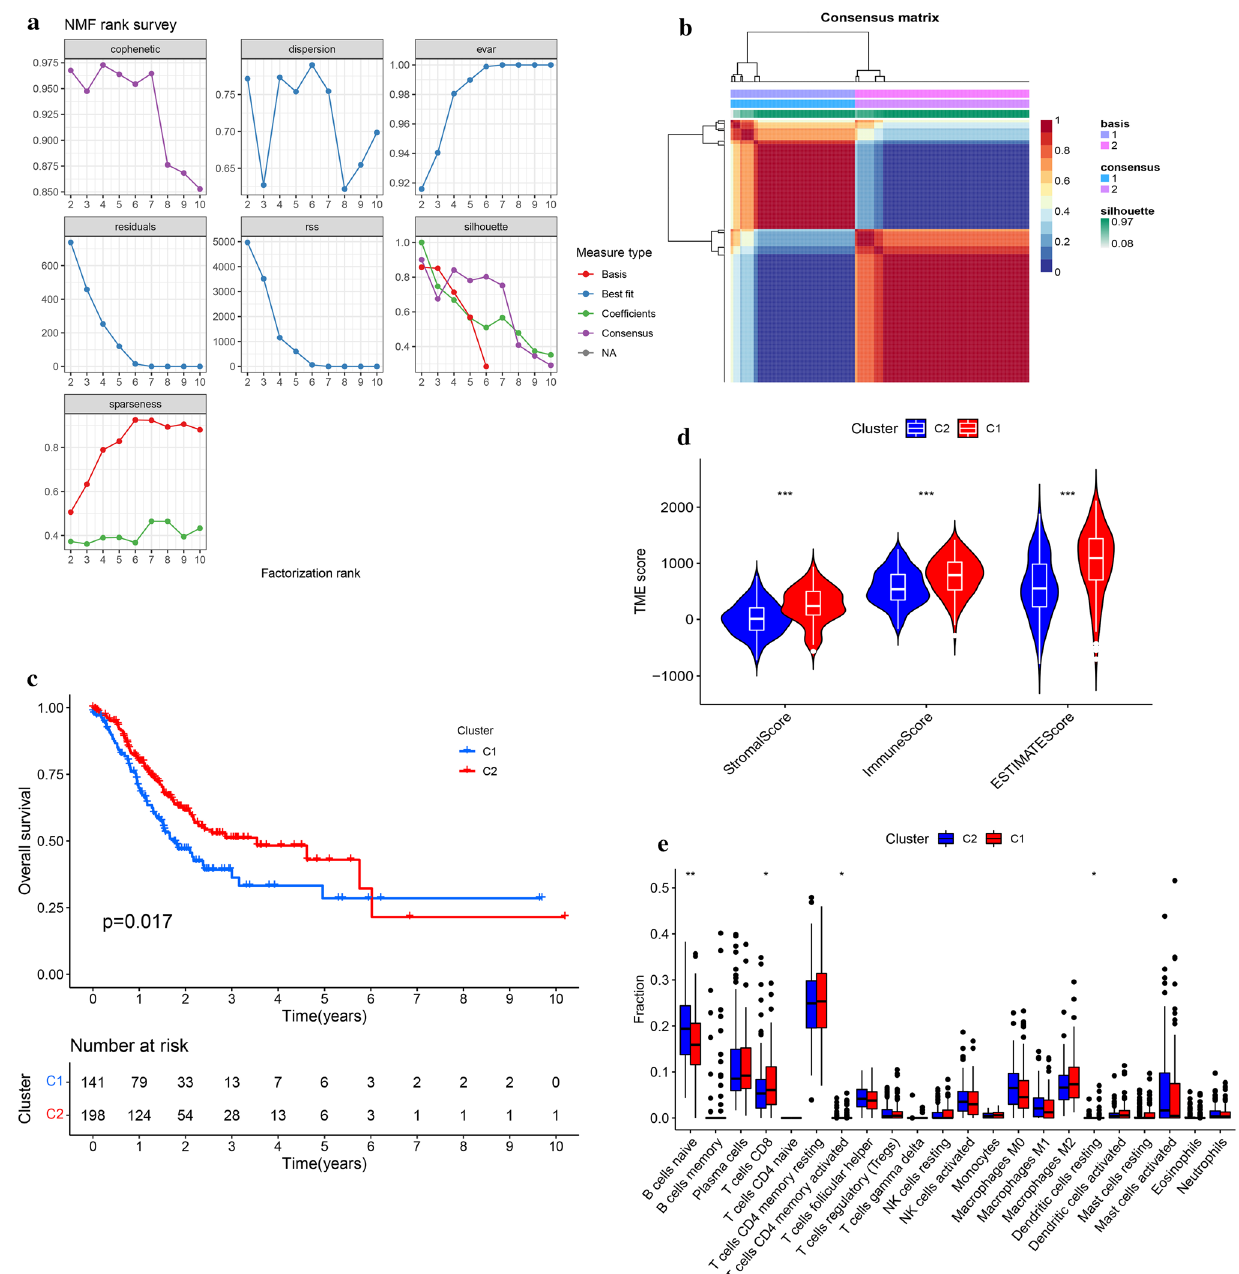
Fig. 3 Identification of DE-IRlncRNAs-based molecular subtypes. a The cophenetic, rss, and silhouette distributions when the number of clusters was set as 2–10. b Consensus map of NMF clustering. c The survival curves of 2 molecular subtypes. d Comparisons of immune, esti- mate, and stroma scores between 2 molecular subtypes. e Comparisons of infiltrating immune cells between 2 molecular